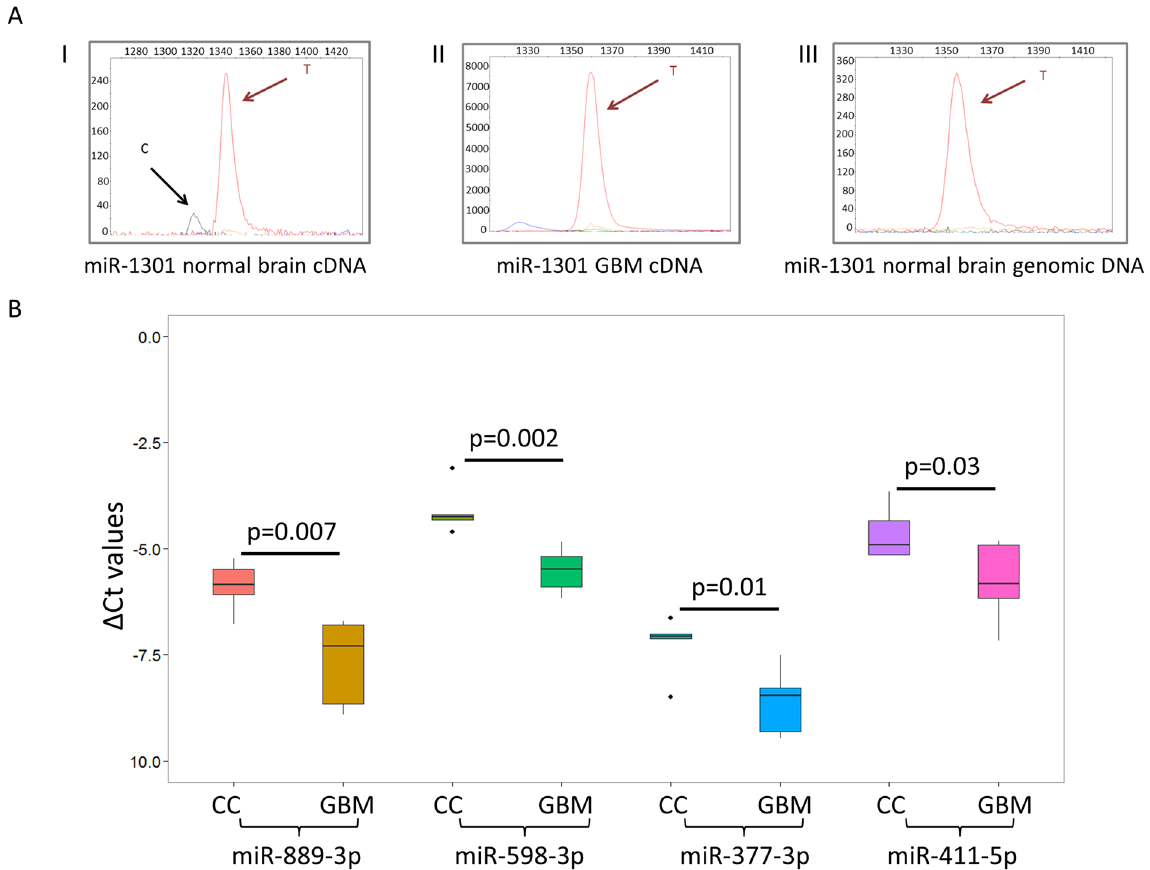
Figure 7. Validation of hypoediting and downregulation of mirna in GBM. ( A ) The X- and Y-axes represents the relative size of the SnaPshot product and relative fluorescence unit (RFU) respectively. One representative example of hypoedited miRNA (mir-1301) in GBM is shown. The editing event observed in normal brain RNA (I) is absent in the GBM tumor RNA (II) and in the normal genomic DNA (III). The SnaPshot specific